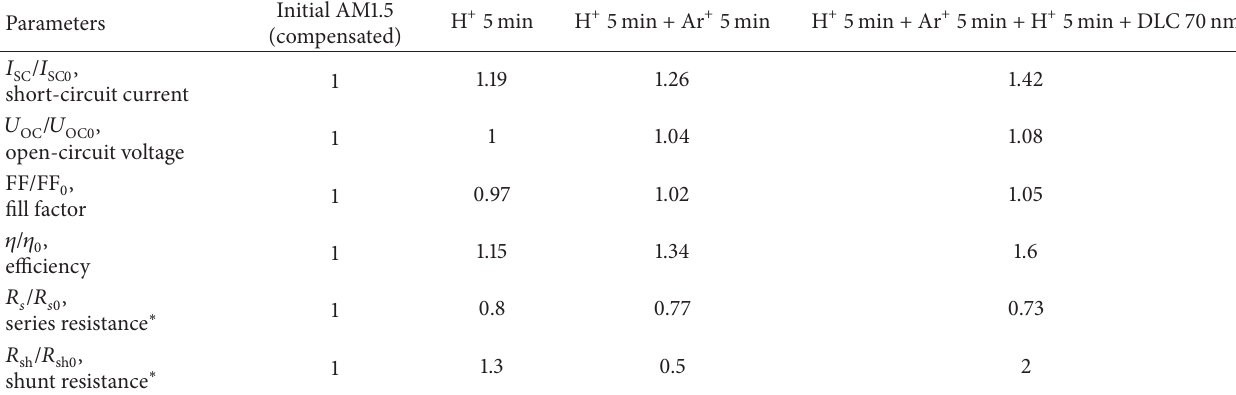
Table 1: The specific parameters of single element of a SC with vertically aligned p-n junction obtained by the compensated technique. Parameters